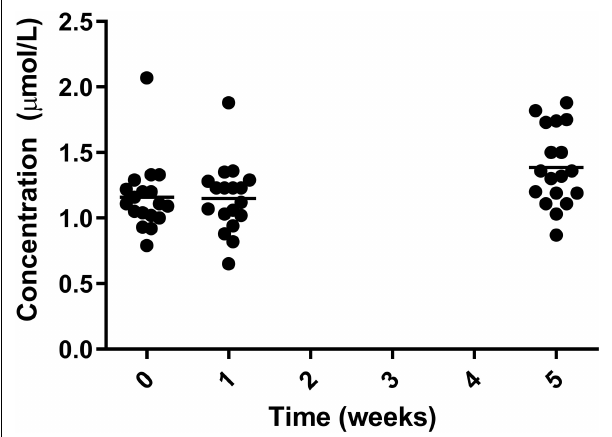
FIGURE 8 | Circulating selenium for the 19 participants who completed the study. The mean of each measurement shown as a solid black line.